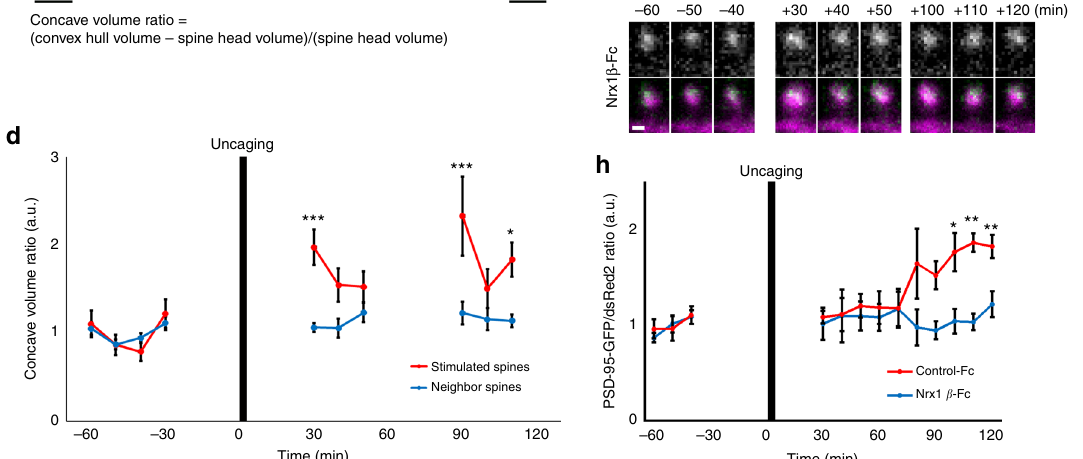
structures. Trans-synaptic interaction between the neurexin and neuroligin is important for formation of excitatory synapses 24,25 and is essential for synaptic plasticity 26 . Moreover, the extra- cellular domains of these proteins can form a superstructure resembling the extracellular structure of the synaptic cleft 27 . Among the four neuroligin isoforms in rodents, neuroligin 1 localizes at excitatory postsynaptic sites 28 and plays a dominant role in hippocampal long-term potentiation 26 . Because the af fi nity of neurexin 1 β for neuroligin 1 is signi fi cantly higher